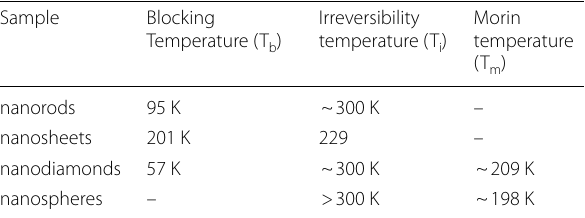
Table 2 ZFC and FC Curve related